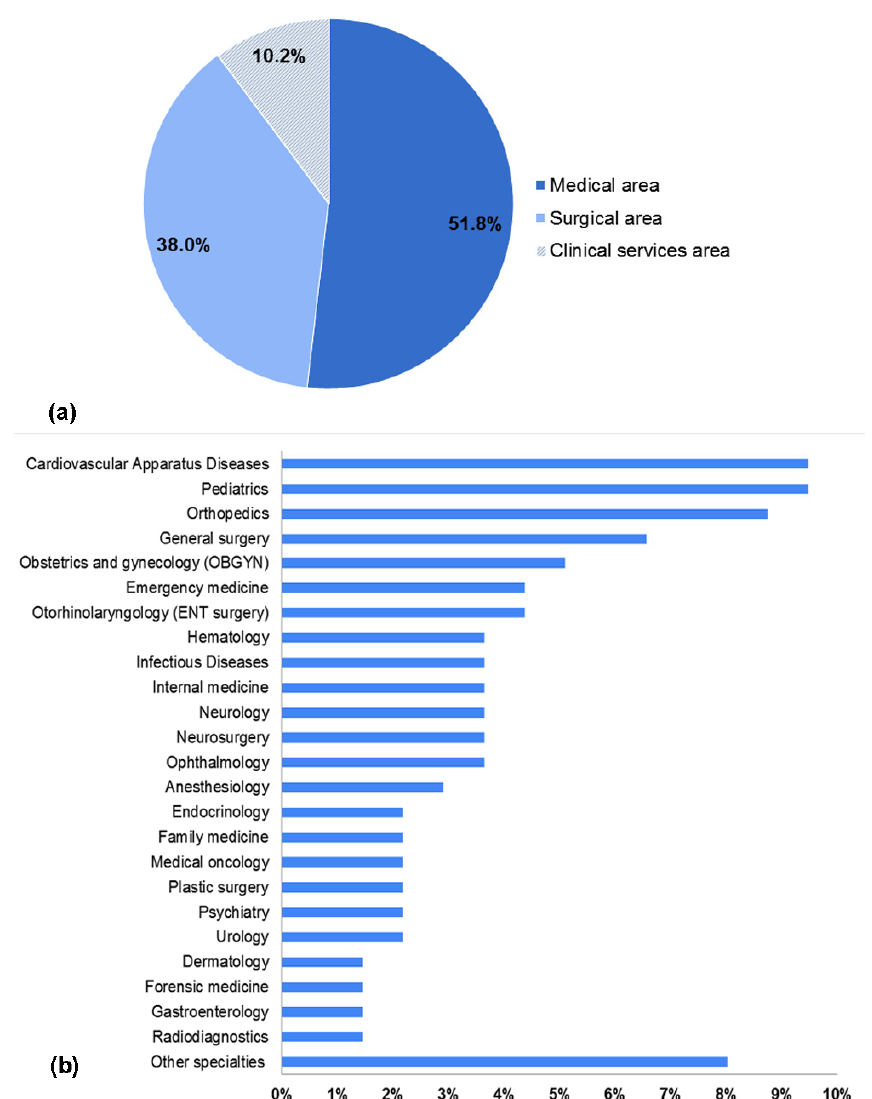
Figure A1. Medical specialties chosen by past and current tutors. ( a ) Pie chart showing selected medical specialties by macro-areas; ( b ) top medical specialties chosen by tutors. Other specialties chosen by the 8% of participants included anatomical pathology, audiology and phoniatrics, food science and human nutrition, maxillofacial surgery, microbiology and virology, nephrology, occupational medicine, pediatric surgery, physical medicine and rehabilitation, and respiratory apparatus diseases.